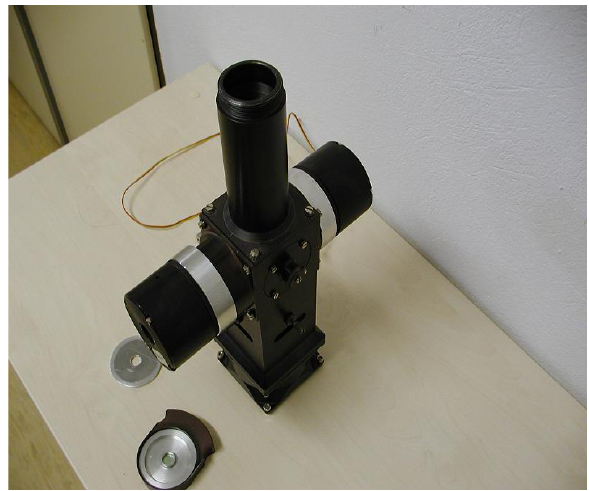
Fig. 1. Body of a photonometer used on coating machine